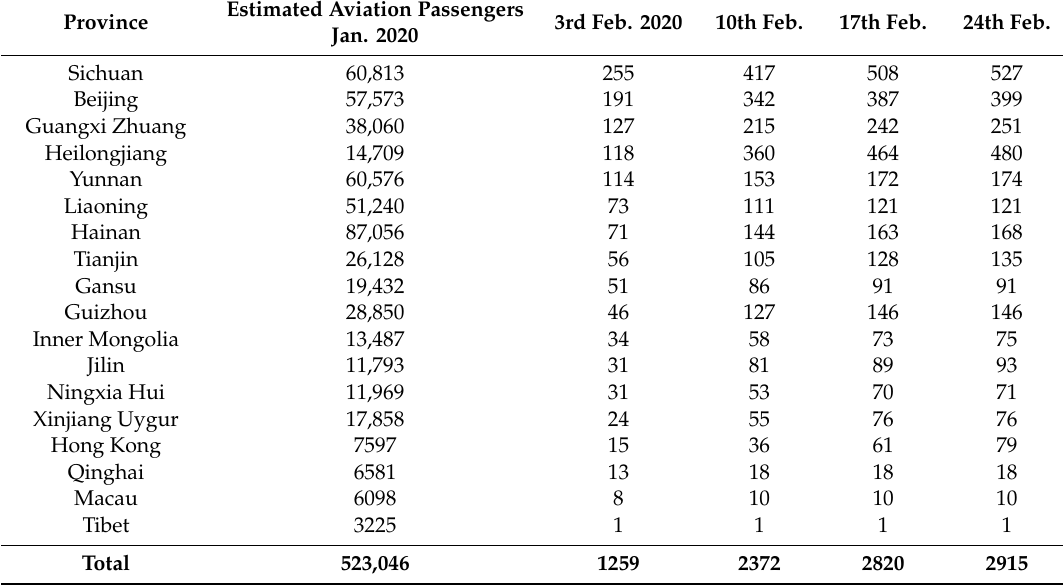
Table 4. Estimated passengers and number of reported cases, China (over 1000 km from Wuhan).